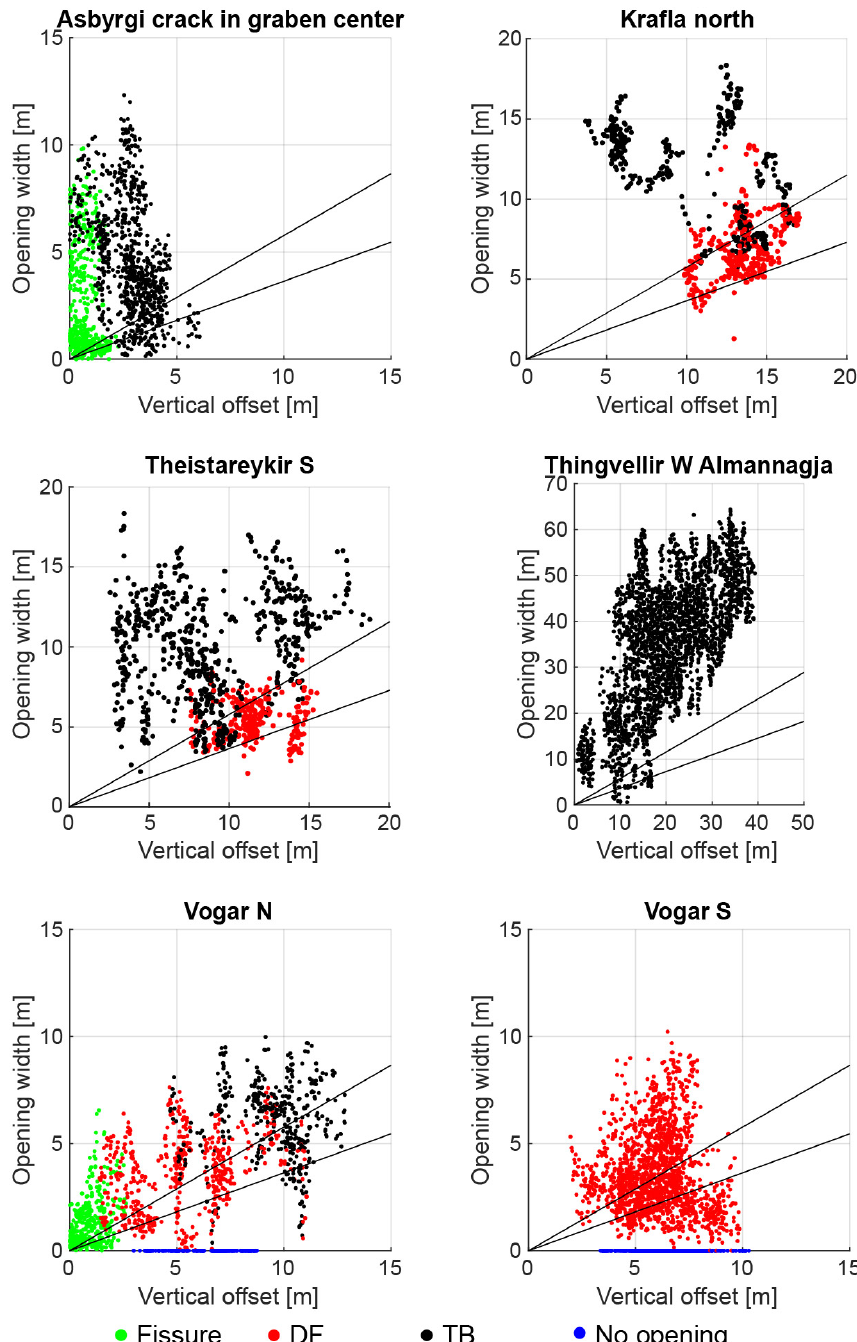
Figure 20. Plots of opening width against vertical offset. The straight black lines represent R for basement fault dips of 60 ◦ (upper one) and 70 ◦ (lower